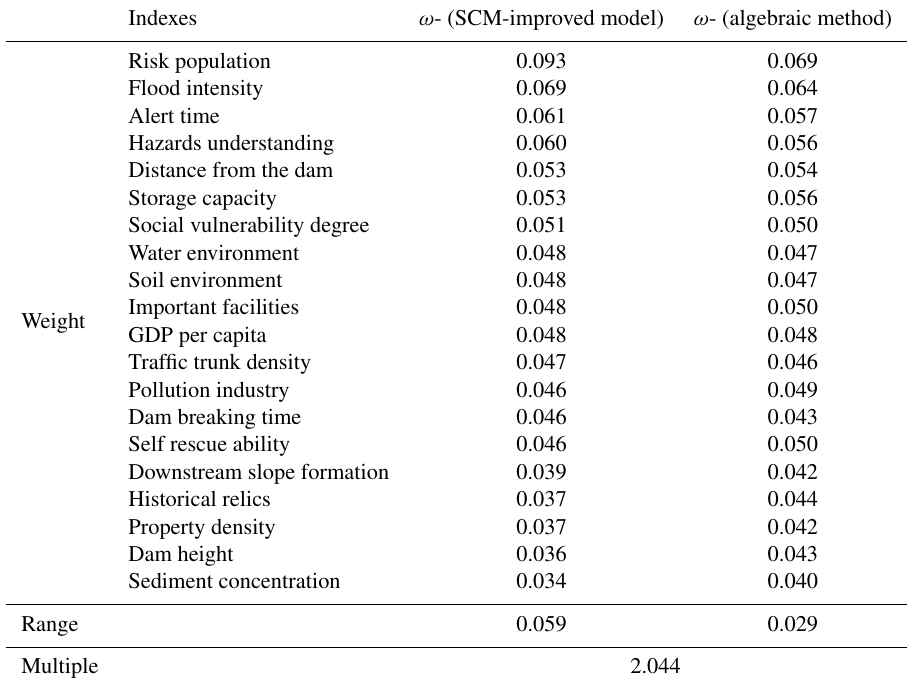
Table 1. Result comparison of the weight